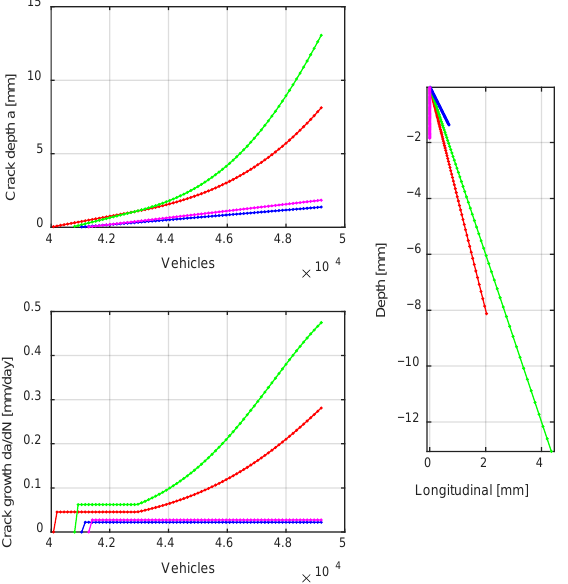
Figure 7. Length, evolution and shape of different predicted cracks.